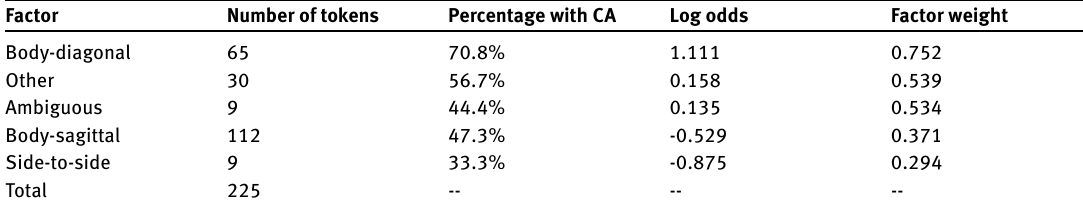
Table 2. Results from statistical analysis investigating a relationship between constructed action and direction